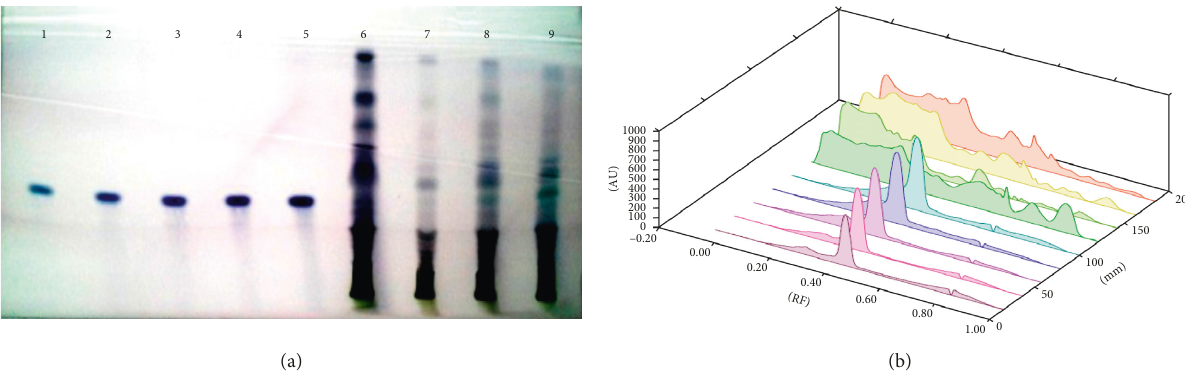
Figure 2: (a) HPTLC fingerprint profile of oleanolic acid (tracks 1–5) in fruit (track 6); leaf (track 7); stem (track 8); and root (track 9) of S. xanthocarpum ; (b) 3D view of densitogram at 530nm.